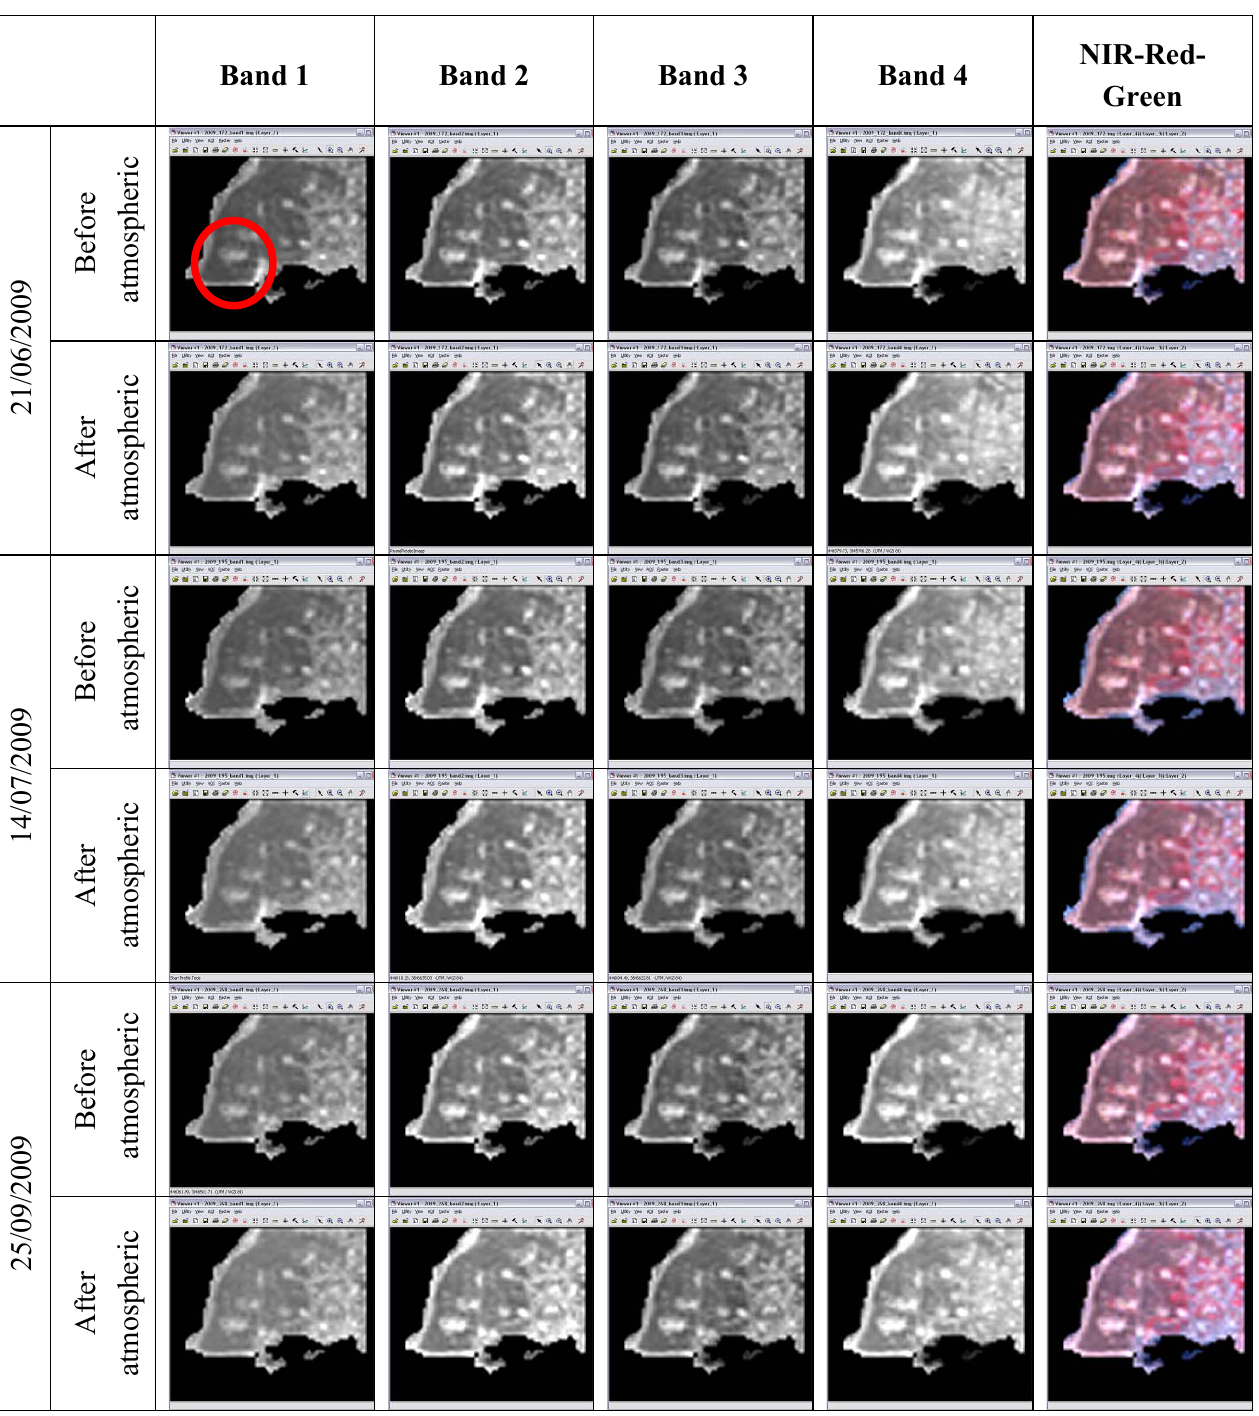
Table 7. Interpretation of the results before and after the modified DP atmospheric correction applied at the Nea Paphos crop mark (the archaeological crop mark in Nea Paphos has been circled, 1st row, 1st image from the